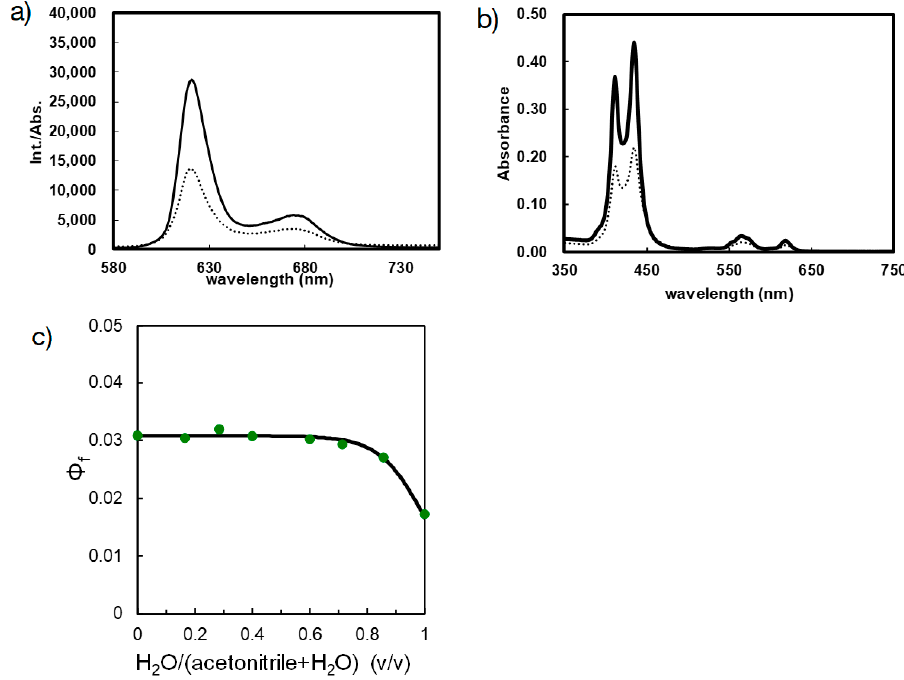
Figure 13. ( a ) Fluorescence (ex. 564 nm) and ( b ) UV–vis absorption spectra of PEG8-5Zn in (plain) 100% acetonitrile and (dotted) 100% ion exchange water. ( c ) Fluorescence quantum yields of PEG8-5Zn in a mixture of water and acetonitrile.